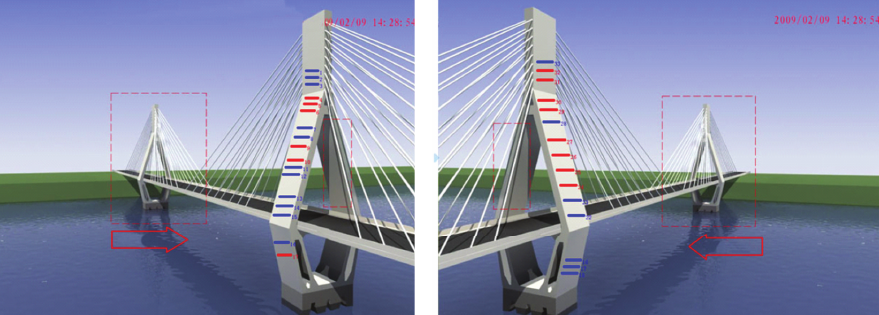
Figure 12: 3D scene of Masangxi Yangtze River Bridge.